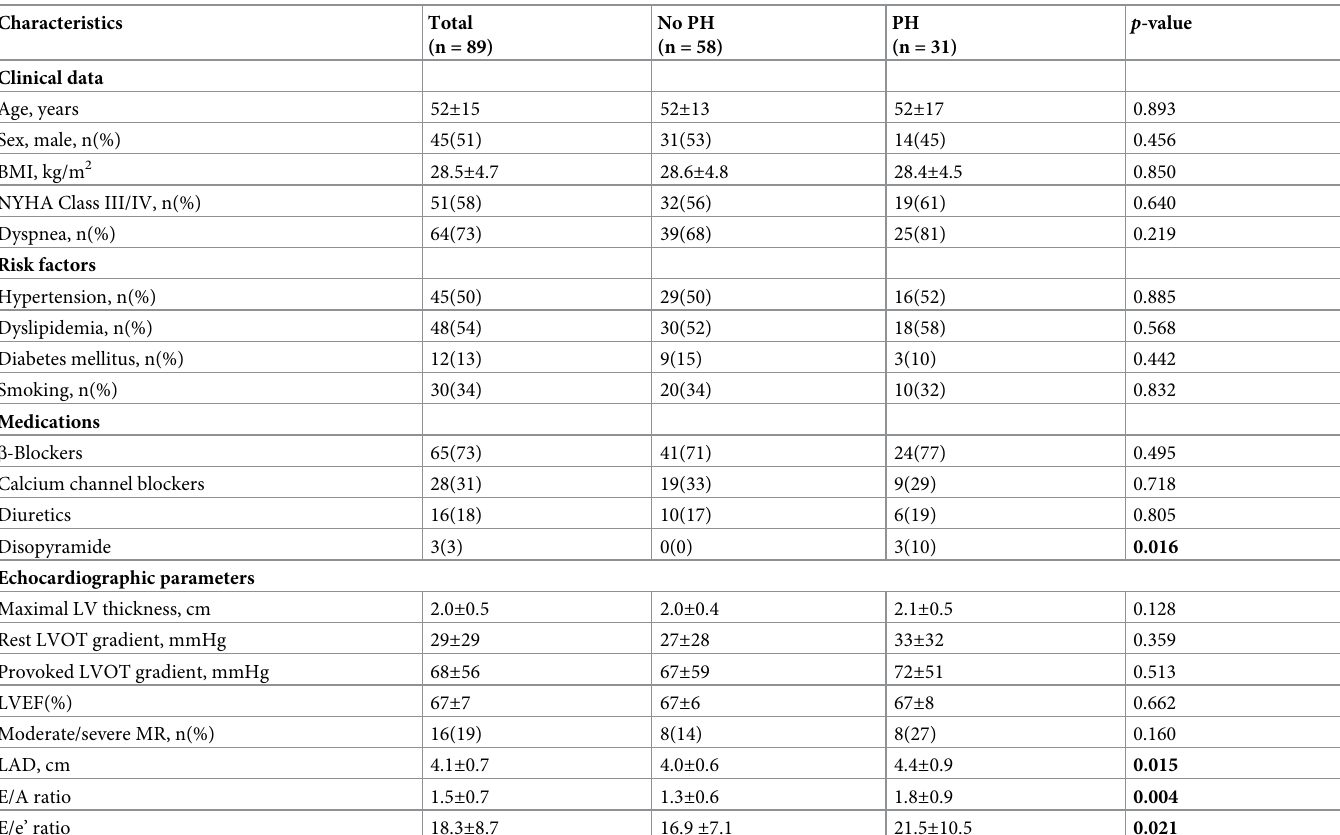
Table 1. Clinical and echocardiographic findings of HCM patients with and without PH.